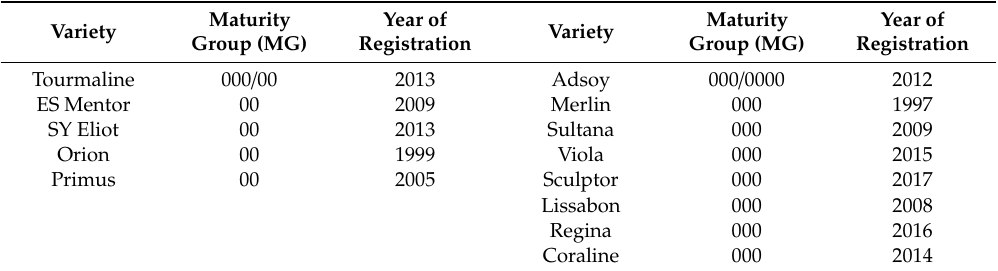
Table 2. Tested varieties according to year of registration and maturity group 1.